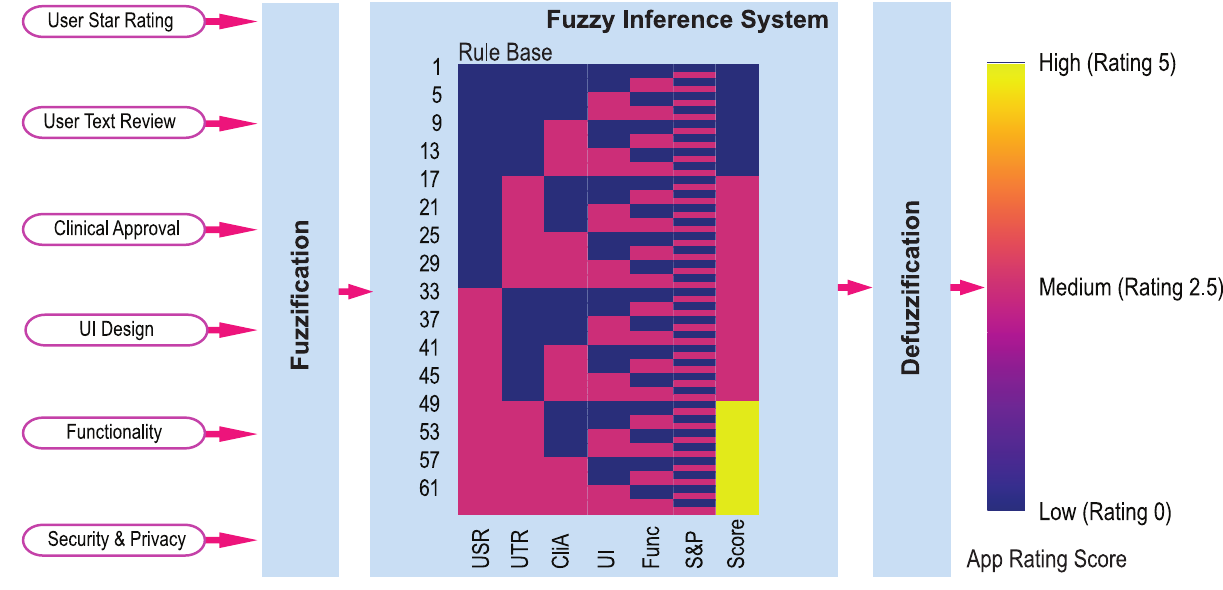
Fig 7. Fuzzy logic based fusion technique which combines the knowledge extracted from the users’ star rating, users’ text review, clinical approval, UI design, functionality and security & privacy and thereby generates a score.